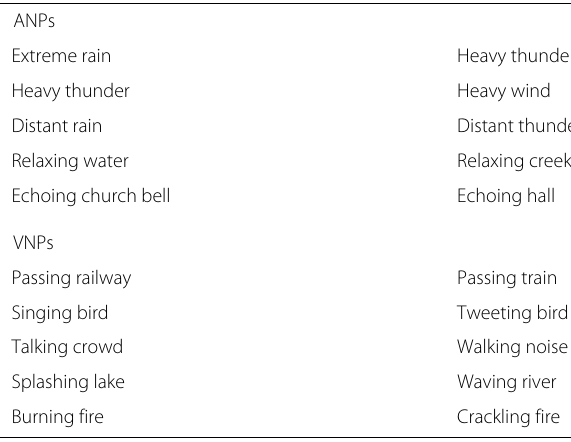
Table 7 Each row correspond to an example of pairs that were highly